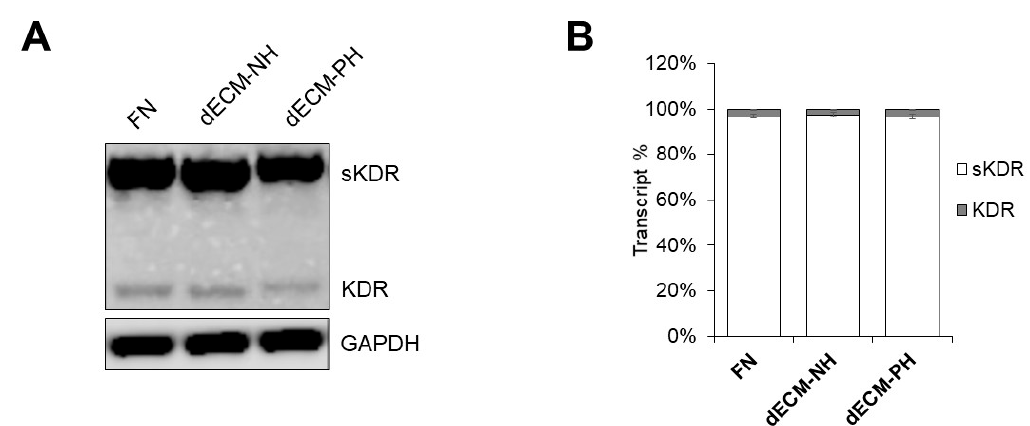
Figure 5. PCR analysis of KDR/VEGFR2 isoforms. Analysis of the relative abundance of mRNA transcripts for the soluble (sKDR) or membrane (KDR) form of KDR/VEGFR2. A representative image is shown ( A ) of an agarose gel run with PCR products evidencing the two KDR/VEGFR2 transcripts, with the housekeeping gene GAPDH as loading control. In order to be able to appreciate the very dim lower band, the gel image is shown as negative. Densitometric quantification ( B ) confirmed no difference among samples in transcript abundance ( n = 3). sKDR: soluble form of KDR. FN: fibronectin coating. dECM-NH: decellularized extracellular matrix from normal hearts. dECM-PH: decellularized extracellular matrix from pathological hearts.